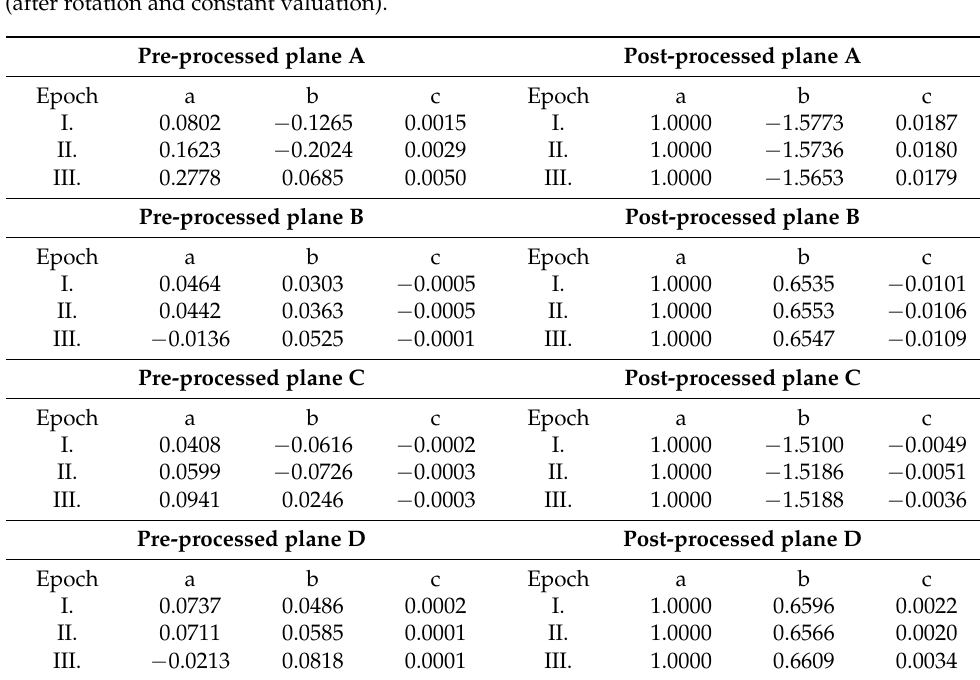
Figure 5. The theoretical approach of the normal vector integration. Table 1. Original normal vectors (after estimation) transformed into final shaped normal vectors (after rotation and constant valuation).